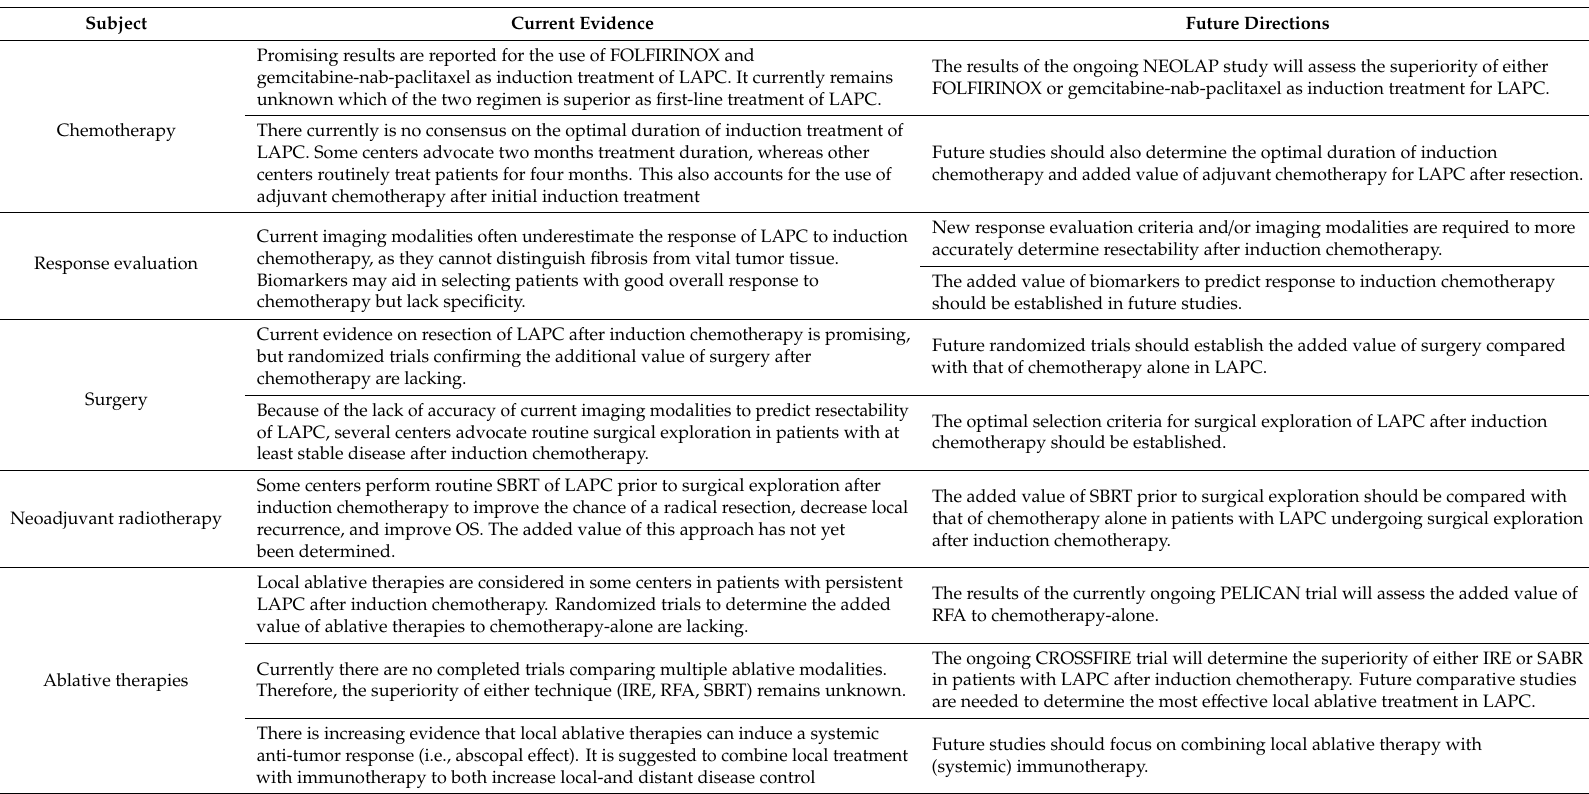
Table 2. Future directions on the management of locally advanced pancreatic